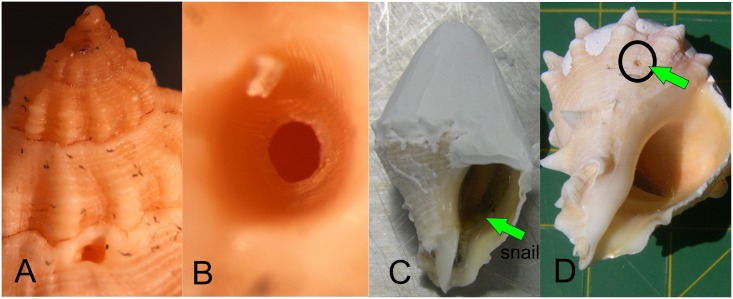
Drilling on the shell of Melongena corona bispinosa by Octopus maya.A) Hole below the apex in the fifth loop suture. B) Dissolution and scraping at the edge of the hole. C) Conch shell coated with dental cement over the posterior end. D) Drilling below the line of the dental cement, and closer to the inner lip of the conch.